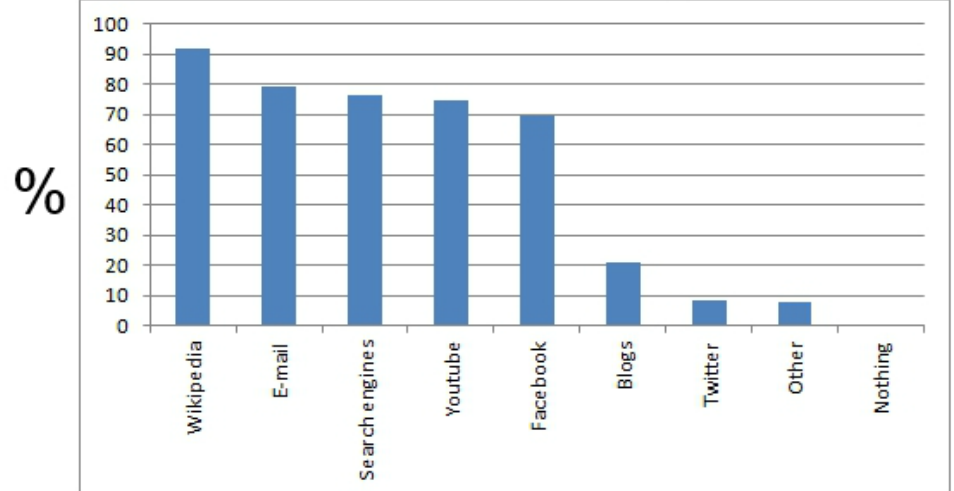
Figure 1. Students enrolled in the course filled in online surveys about the online resources they use in their studies. The y axis represents the percentage of students that chose the particular answer.